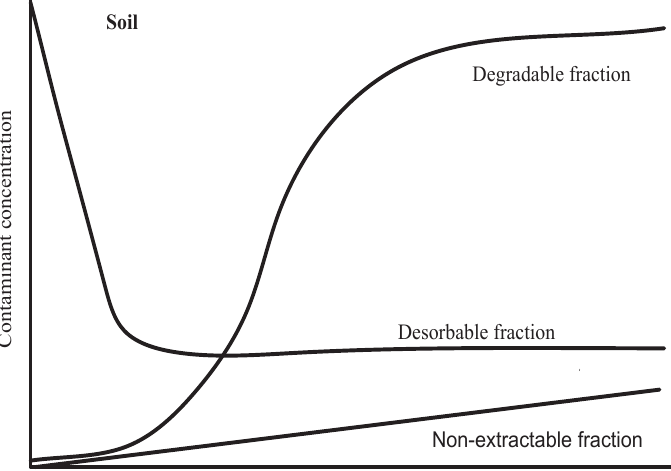
Figure 1. The influence of contact time on the extractability and bioaccessibility of a contaminant. Adapted from